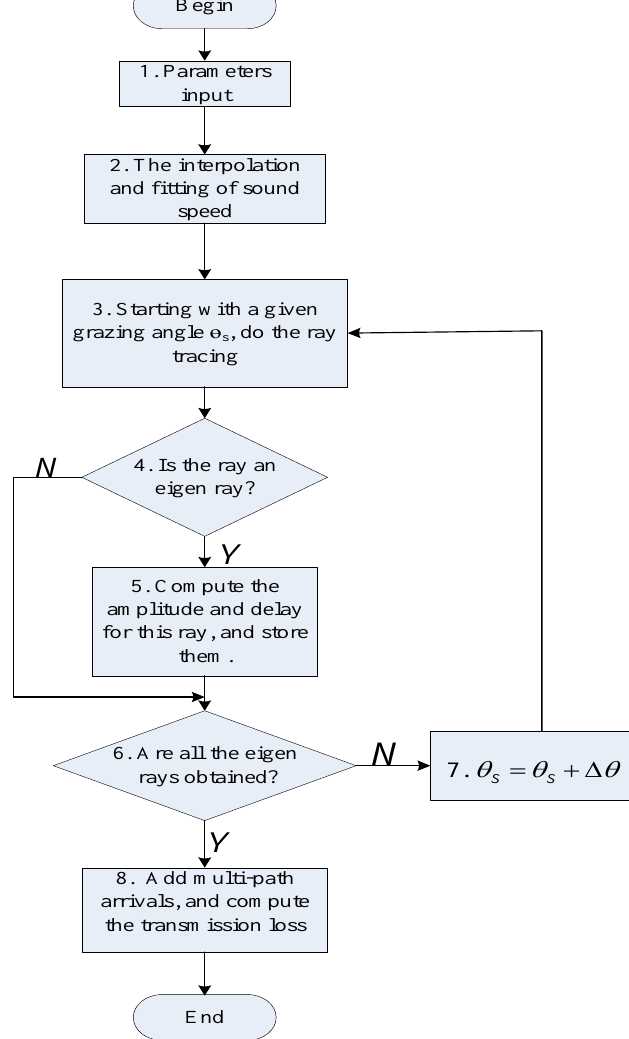
Figure 6. Flowchart of the implementation of SAM.